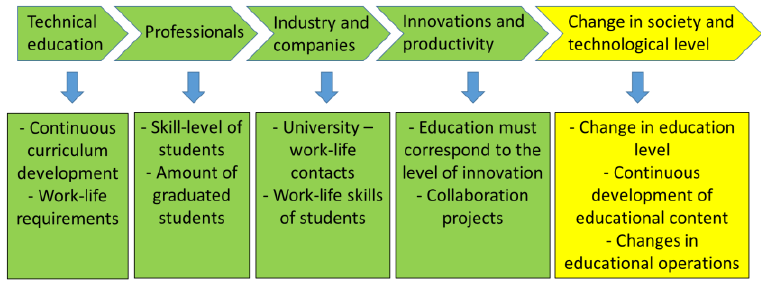
Fig. 5. Demands set to education by knowledge transfer factors. Modified from [6], [16],